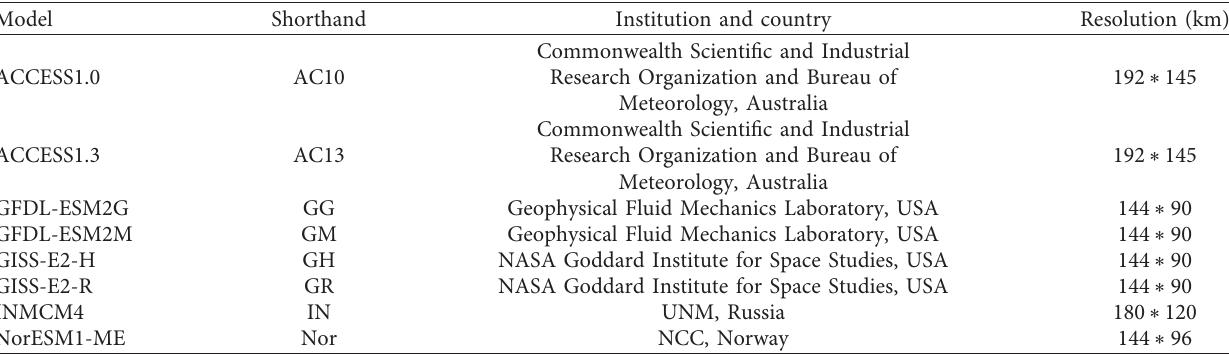
Figure 1: Sketch map of study area. Table 2: Information of the 8 CMIP5 GCMs.